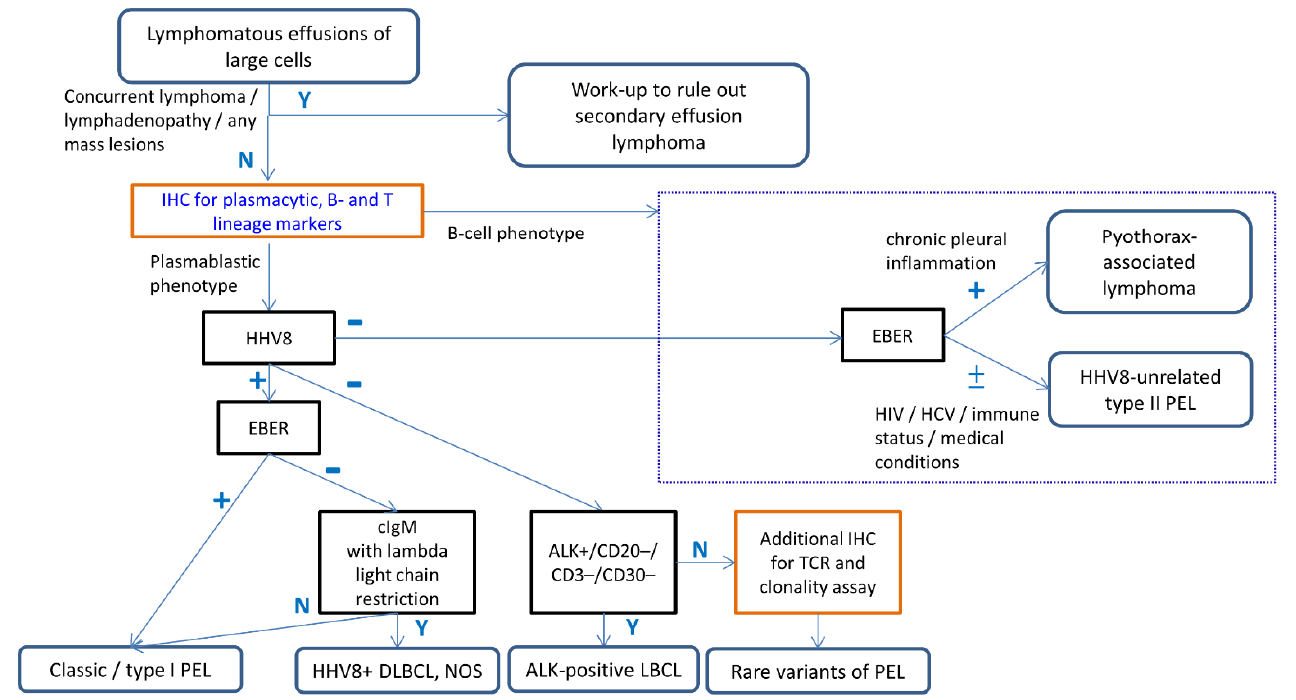
Figure 4. Algorithmic approach incorporating ancillary studies for the diagnosis of PEL. The initial step is the assessment of clinical history of concurrent lymphoma or lymphadenopathy to exclude secondary effusion lymphoma. The proposed initial panel for suspicious PEL includes one marker for each of B, T, and plasma cell lineages. After determining the cellular lineages (plasmablastic vs. B-cell phenotype), HHV8 immunostain and EBER should be performed in all cases of large cell-predominant lymphomatous effusion. When encountering indeterminate examples, a large panel of B, T, and plasma cell markers, as well as clonality assay will be helpful in determining cellular lineages. Careful clinicopathological correlation, including HIV infection, history of immunodeficiency, chronic pleural effusion, other medical conditions, and additional ancillary studies, is needed for the differential diagnosis of PEL with its mimickers. Abbreviations: Y; Yes, N; No.